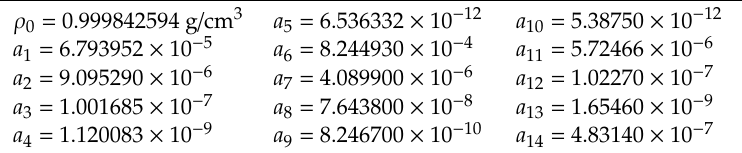
Table 1. Density estimation coe ffi cients.